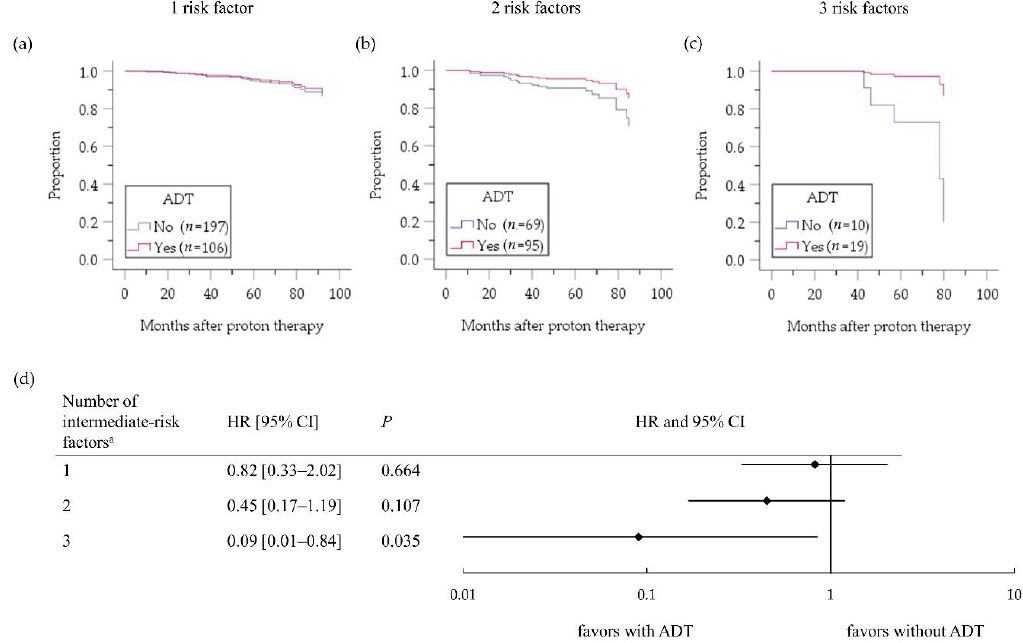
Figure 3. Cumulative survival function according to the number of risk factors; ( a – c ) and forest plots ( d ) assessing the risk of biochemical relapse in intermediate-risk PC patients according to the number of intermediate-risk factors a . ADT, androgen deprivation therapy; HR, hazard ratio; CI, confidence interval. a The three intermediate-risk factors are T stage 2b–2c, PSA level 10–20 ng / mL, and Gleason score 7.